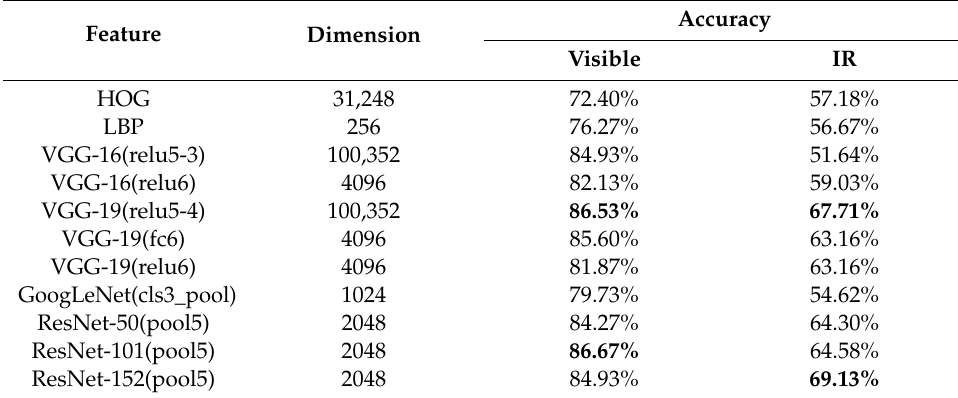
Table 1. Classification accuracy of di ff erent input features.